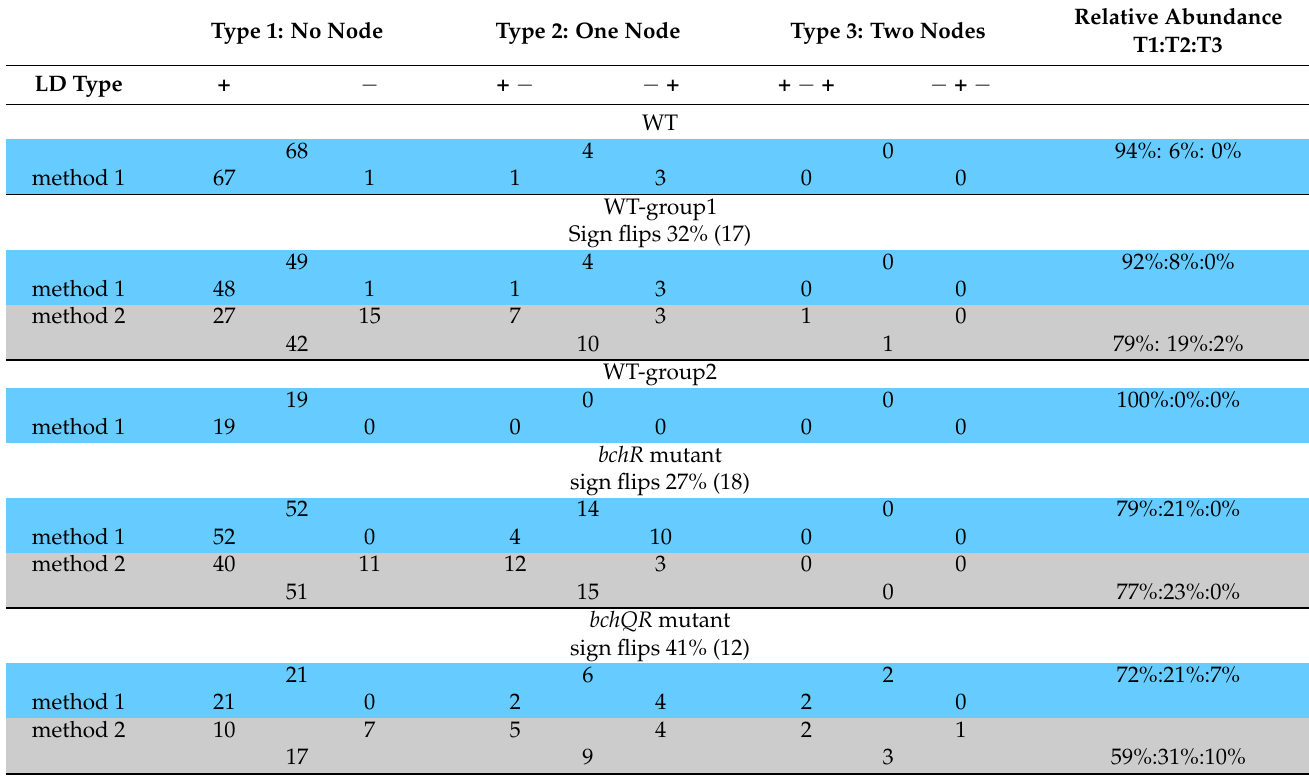
Table 2. Summary of the different types of single-chlorosome LD spectra. The colour code refers to the colour code used in Figure 5 for distinguishing the two reconstruction protocols, method 1 (blue) and method 2